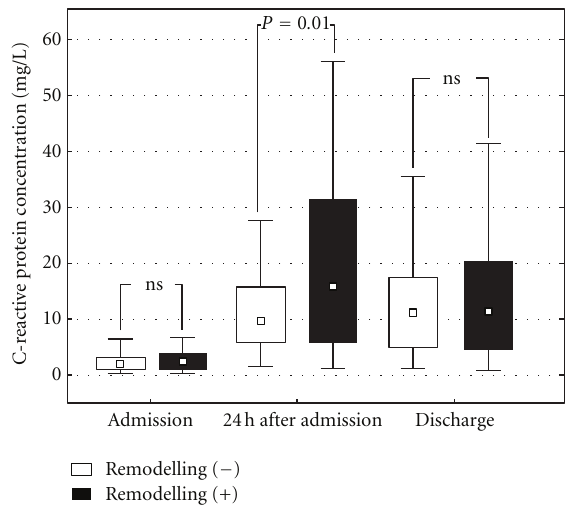
Figure 1: Plasma C-reactive protein concentration on admission, 24h after admission and at hospital discharge in patients after acute ST-segment elevation myocardial infarction with and without left ventricular remodelling at 6 months after hospital discharge. Results are presented as medians, interquartile ranges, and ranges.